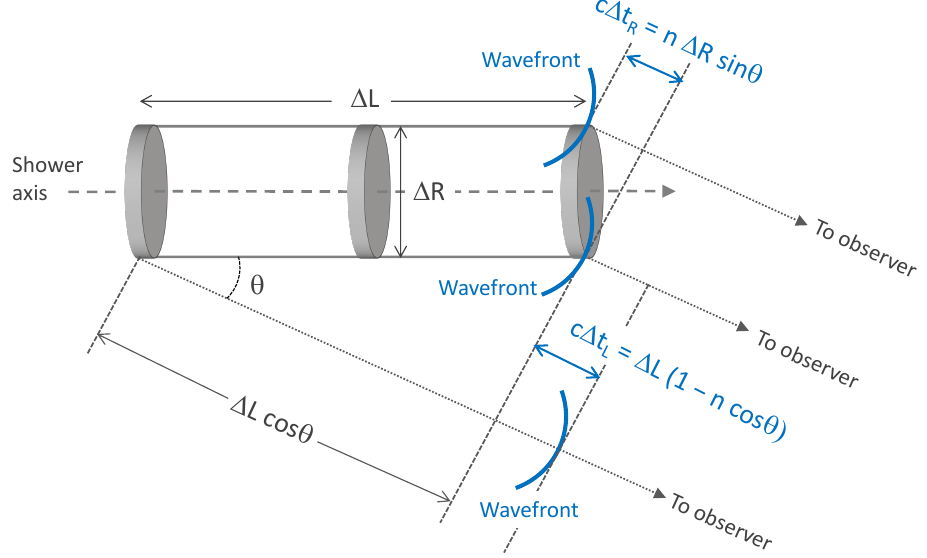
Figure 4. Sketch of the toy model of shower development over the lifetime of the shower in Section 5.1. A shower has an effective length ∆ L and width ∆ R , giving characteristic time delays of ∆ t L and ∆ t R between wavefronts at the observer located in the Fraunhofer region at angle θ to the shower axis. See text for more